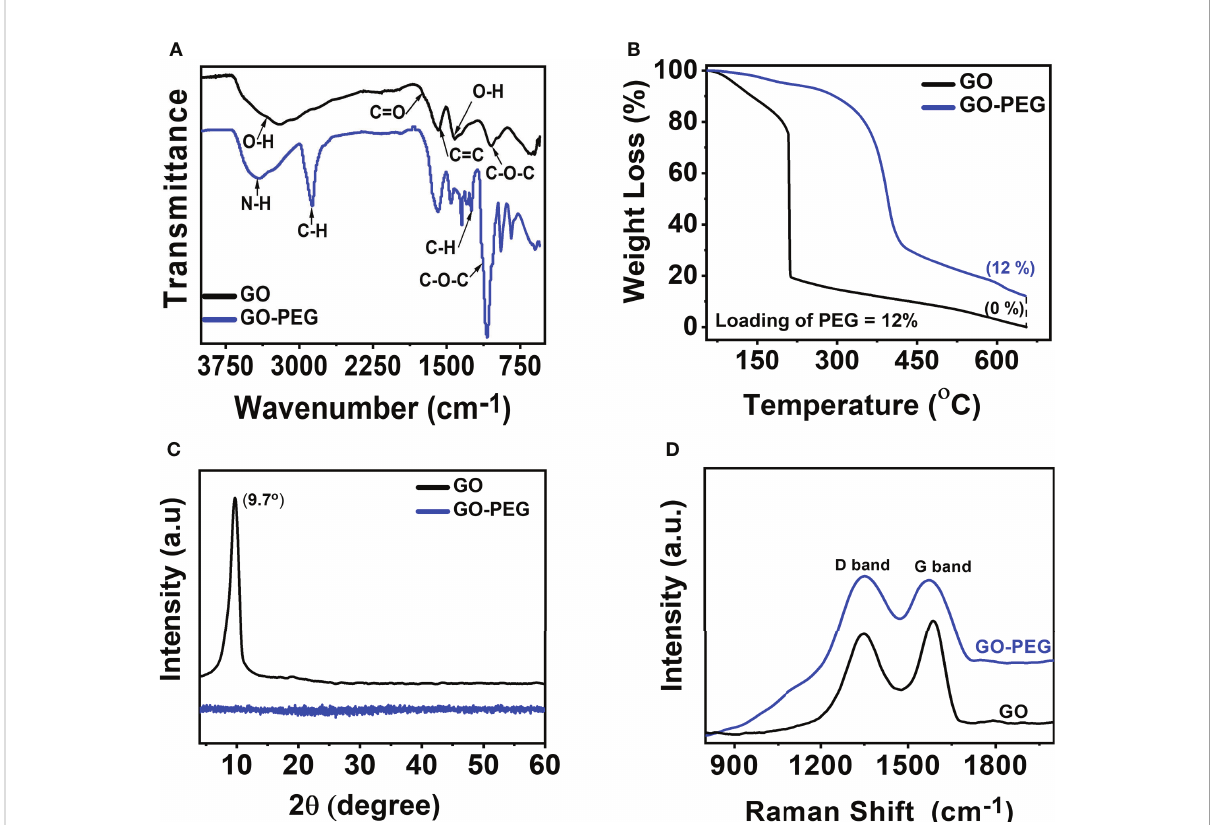
FIGURE 2 Characterization of GO and GO-PEG nanoparticles. (A) FTIR, (B) TGA, (C) PXRD, and (D) Raman